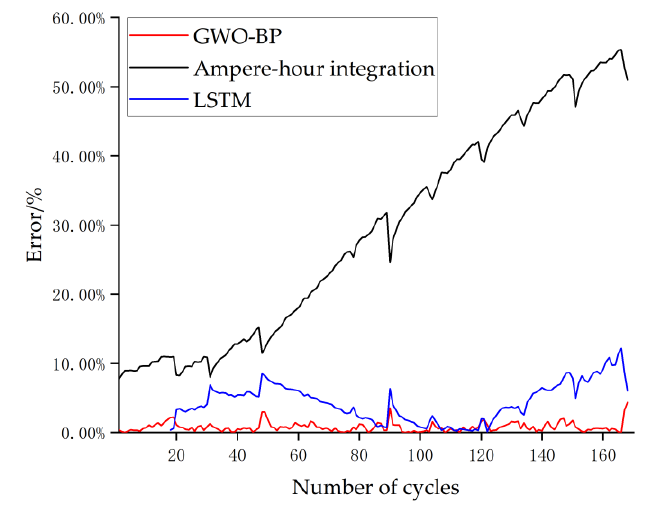
Figure 13. SOC estimation error for No. 5 battery.